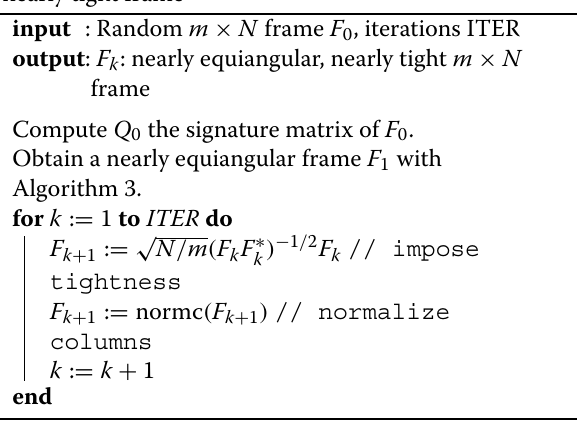
Algorithm 4: Construction of a nearly equiangular, nearly tight